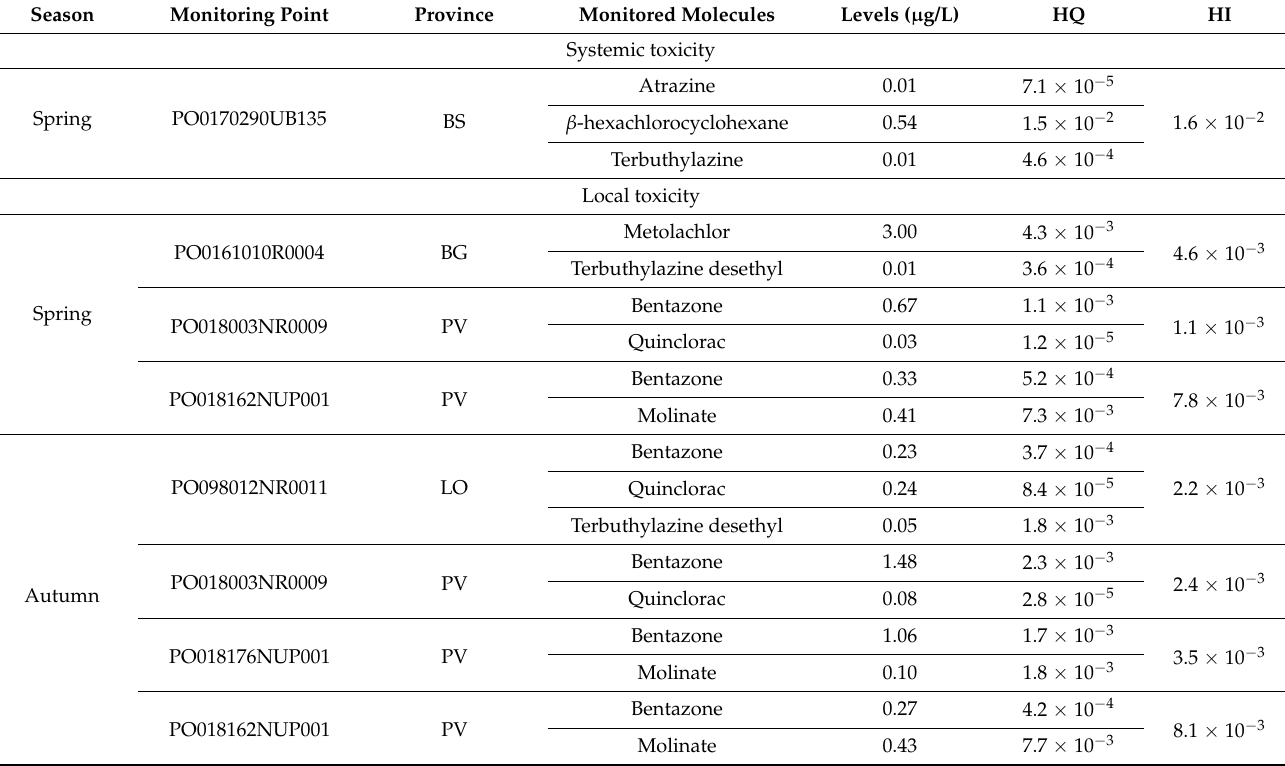
Table 6. Summary of monitoring points where two or more monitored molecules, grouped by systemic or local toxicity, exceeded the EQS multiple . For each molecule, the risk for health for an adult ingesting 2 L of drinking water per day was assessed as hazard quotient (HQ). For each groundwater sample the cumulative risk was assessed as hazard index